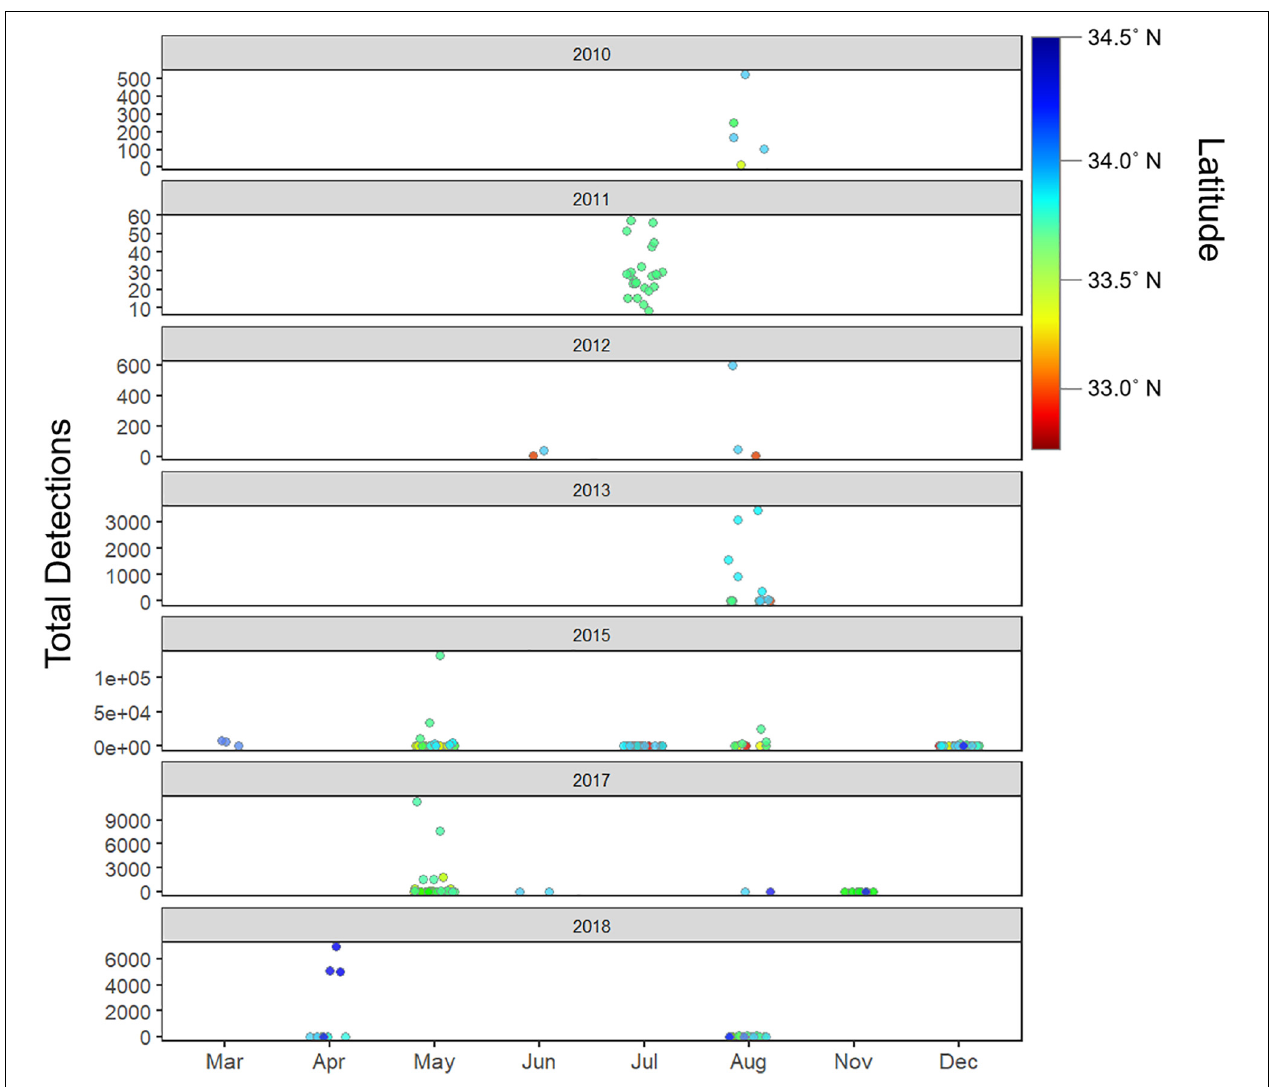
FIGURE 8 | Total detections by year, latitude and month (seasons) – detection patterns show seasonality, and interannual latitudinal variability, with August serving as the month with peak overall detections across all years combined.